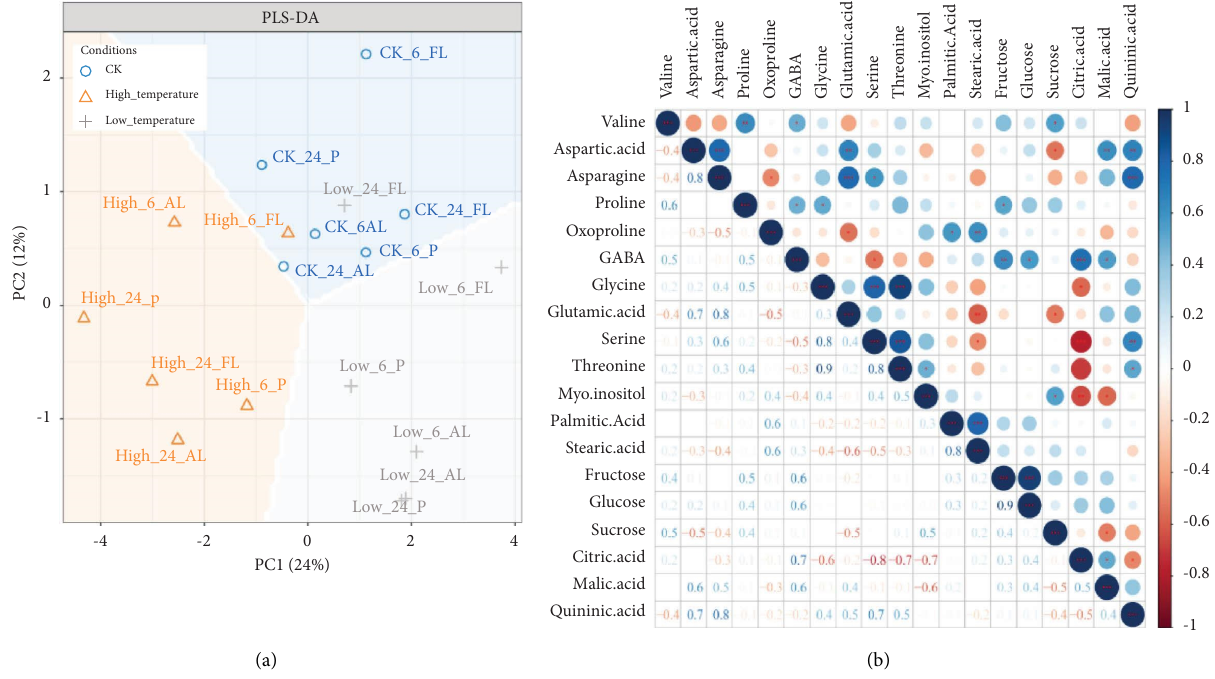
Figure 5: Multivariate analysis of metabolites in Valencia orange fruits with diferent temperature treatments. (a): PLS-DA score plot. Te blue circle represents the control group (CK); the orange triangle represents high-temperature treatment; the gray cross represents low- temperature treatment. (b): Correlation analysis between metabolites. Te color depth and the dot size indicate the correlation strength; red indicates a negative correlation, and blue indicates a positive correlation. ∗∗∗ indicates p < 0 . 001, ∗∗ indicates p < 0 . 01, and ∗ indicates p < 0 .